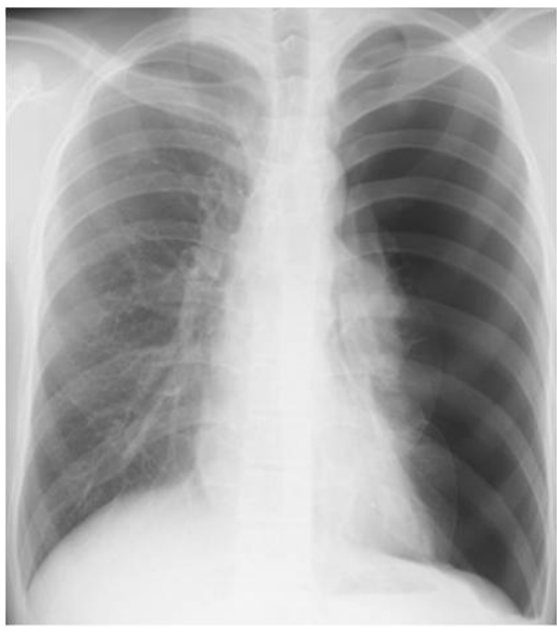
Figure 3. Chest roentgenogram showed left